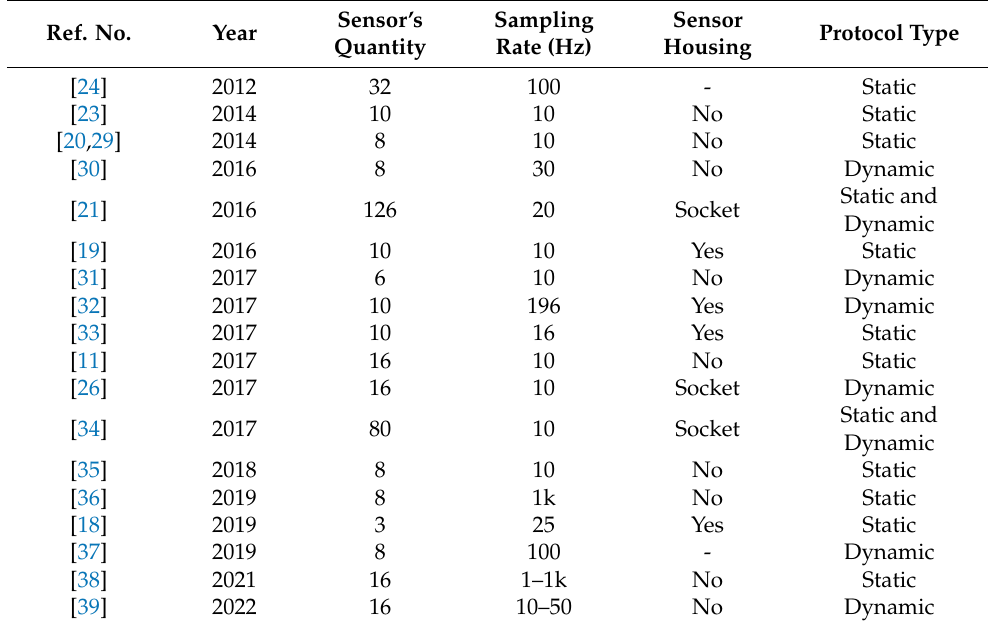
Table 1. Literature review of FMG-based studies. Ref.